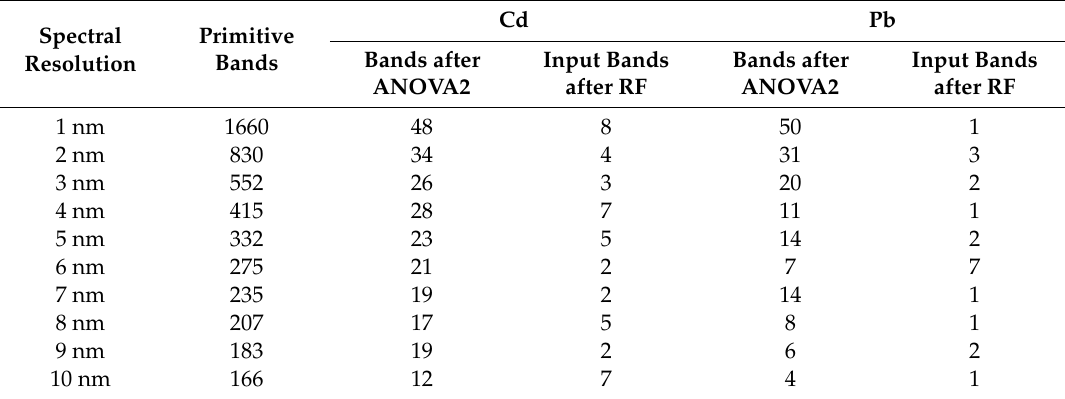
Table 2. Details of the band number at each spectral